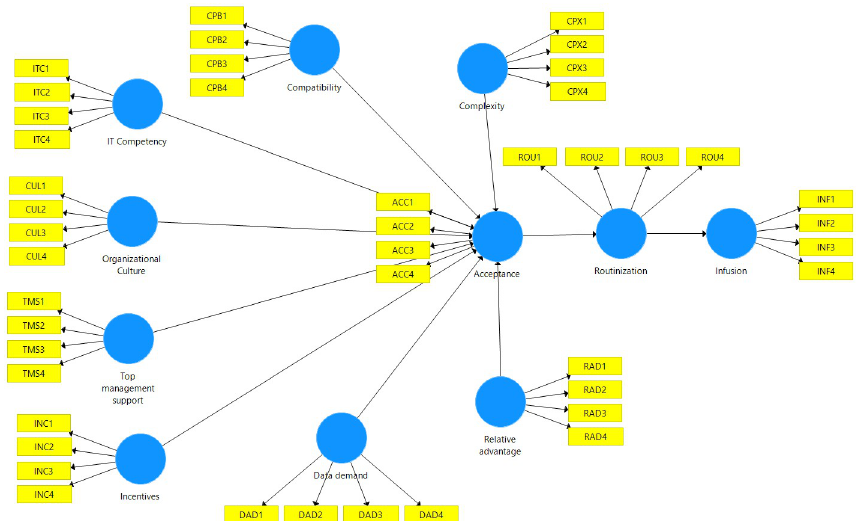
Fig 3. The formative and reflective constructs modeling in SmartPLS